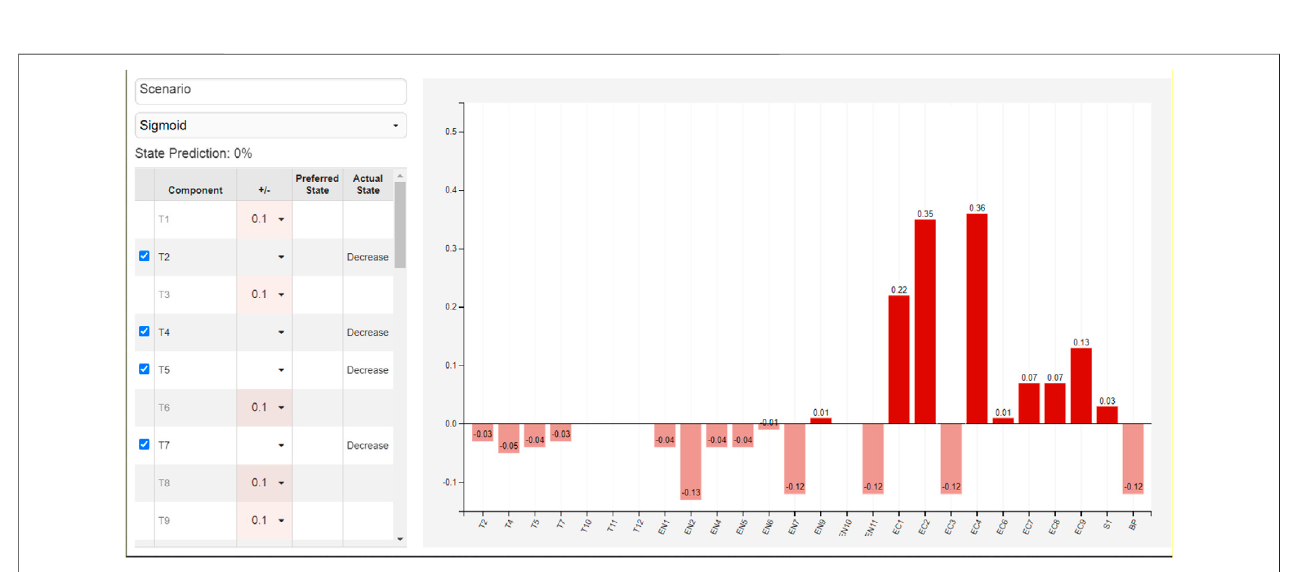
FIGURE 7 | Worst case scenario for the Schizochytrium limacinum sp with sigmoid learning and for the impact of the technological criteria.